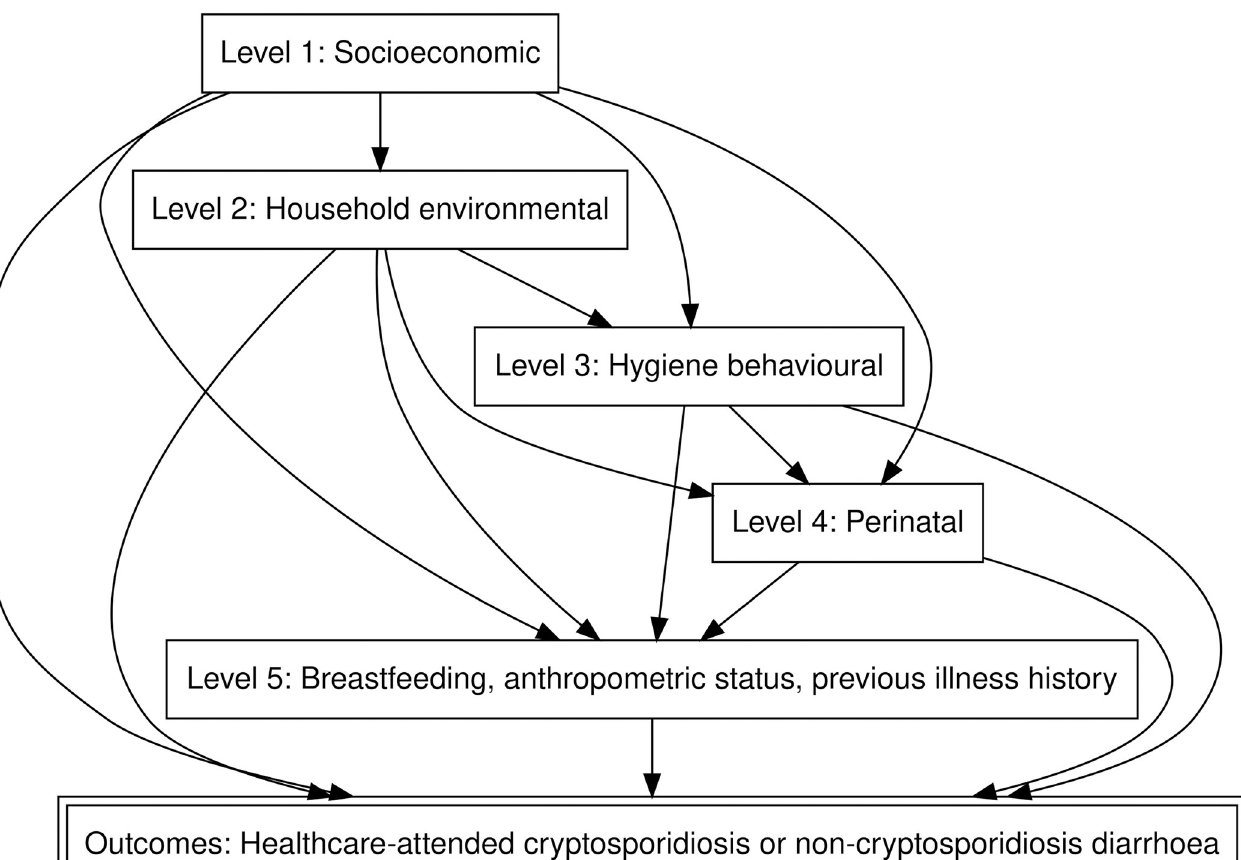
Fig 1. Hierarchical conceptual framework for the relationship between the putative risk factors for cryptosporidiosis and non-cryptosporidiosis diarrhoea.